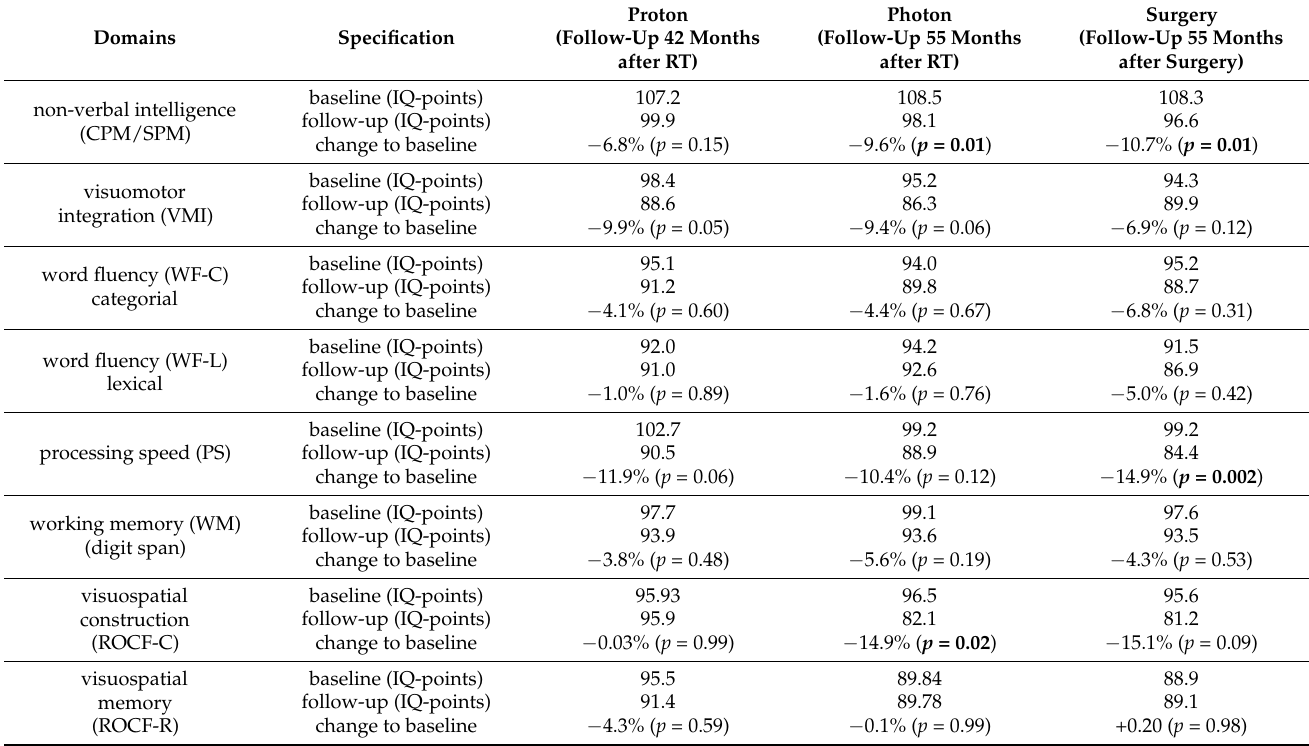
Table 2. Neurocognitive testing from baseline to latest follow-up, organized by domain and treatment modality.